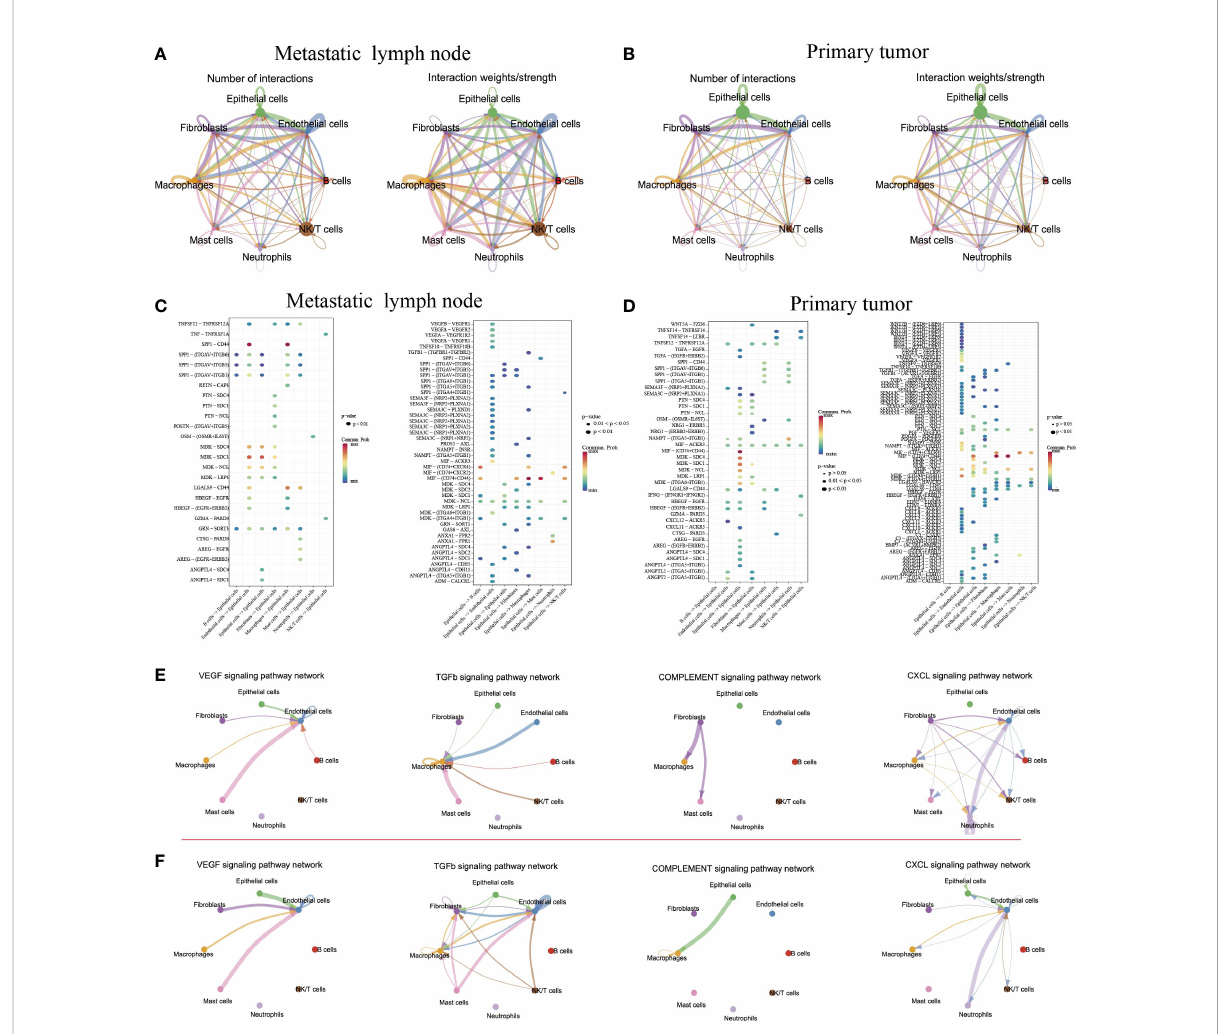
FIGURE 6 Intercellular and molecular interactions in primary tumor and metastatic lymph node. Chord diagram showing the number and strength of interactions in metastatic lymph nodes (A) and primary tumors (B) . Bubble diagram depicting the signi fi cant ligand – receptor interactions of epithelial cells with other cell types in metastatic lymph nodes (C) and primary tumors (D) . Signi fi cant signaling pathways of cell – cell connections in metastatic lymph nodes (E) and primary tumor (F)